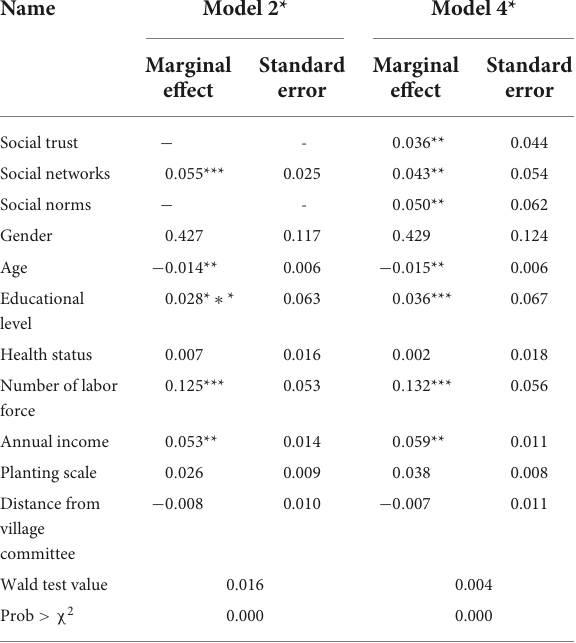
TABLE 6 Estimated results of the impact of social capital on farmers’ green control technology (GCT) adoption behavior (instrumental variable method).